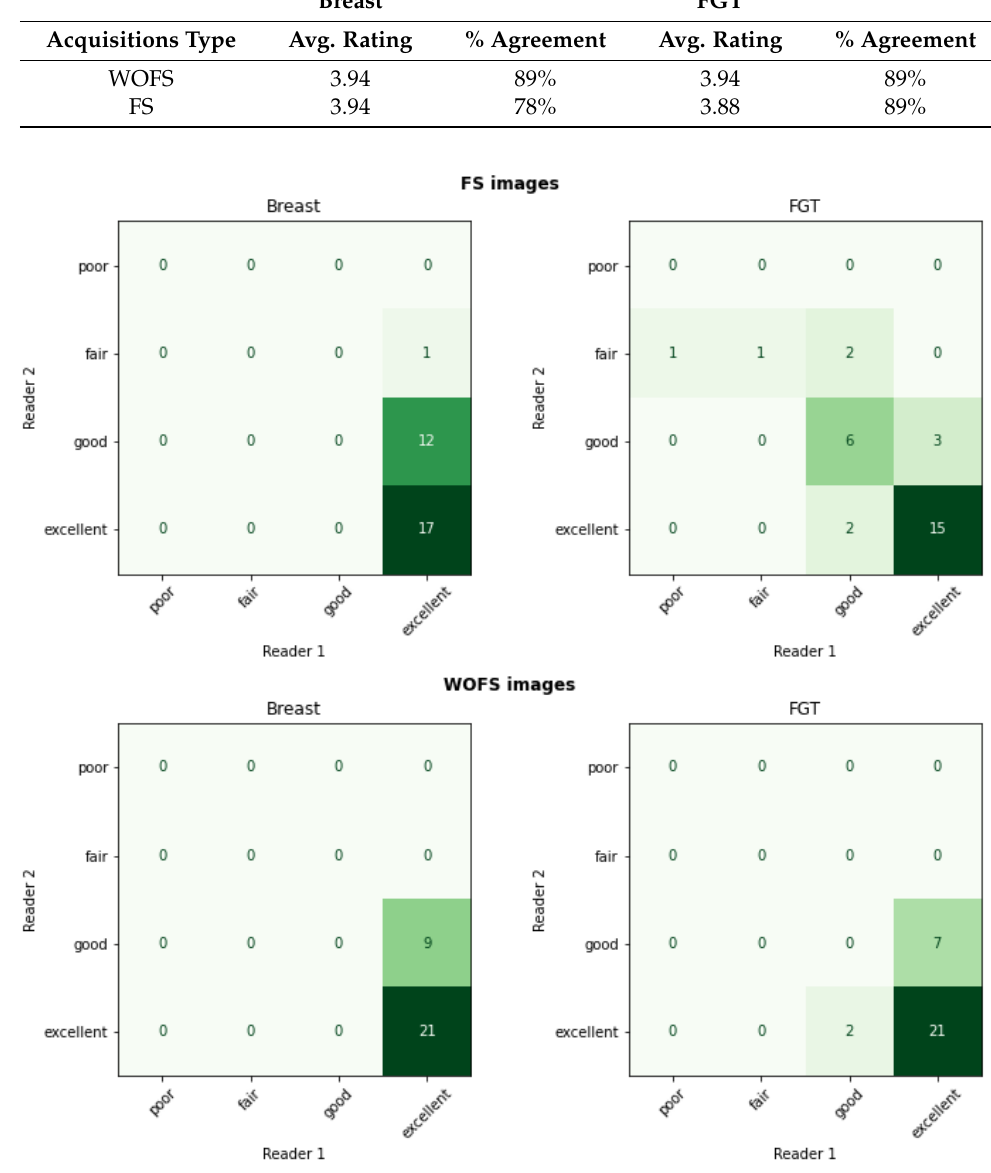
Figure 6. External test set results (n = 30 patients, 60 acquisitions (30 WOFS, 30 FS)). Reader study con- fusion matrix comparing the ratings (1—Poor, 2—Fair, 3—Good, 4—Excellent) from the two